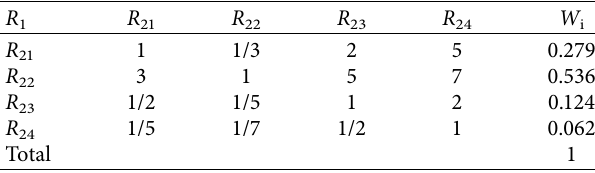
Table 5: Weight of teaching condition in second-level indicators.